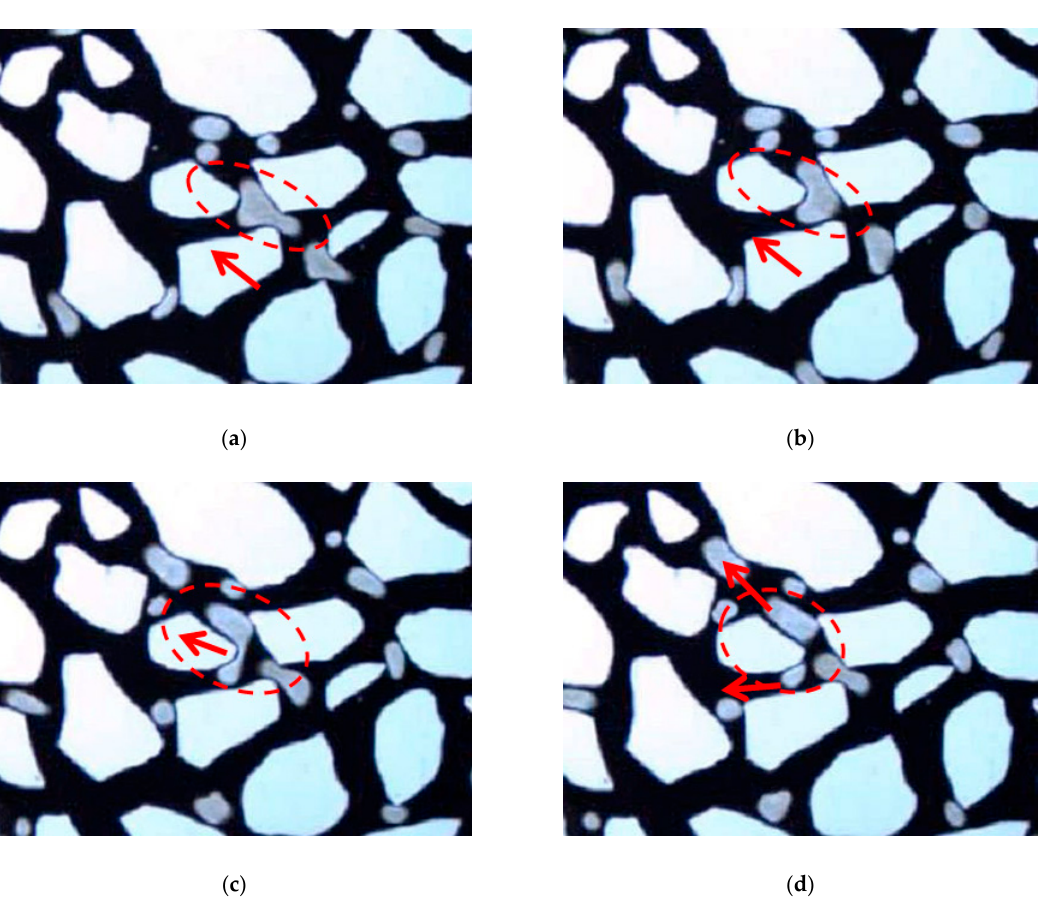
Figure 10. A continuous process whereby the bubble goes through a pore throat and then splits into small bubbles: ( a ) bubble deforms; ( b ) bubble is elongated; ( c ) bubble gets thinner; ( d ) bubble splits.